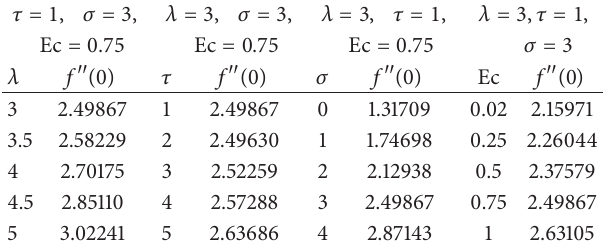
Table 3: The skin friction coefficient 𝑓 󸀠󸀠 (0) for different values of 𝜆, 𝜏, 𝜎 , and Ec (𝐾 = 2, Pr = 0.733) .